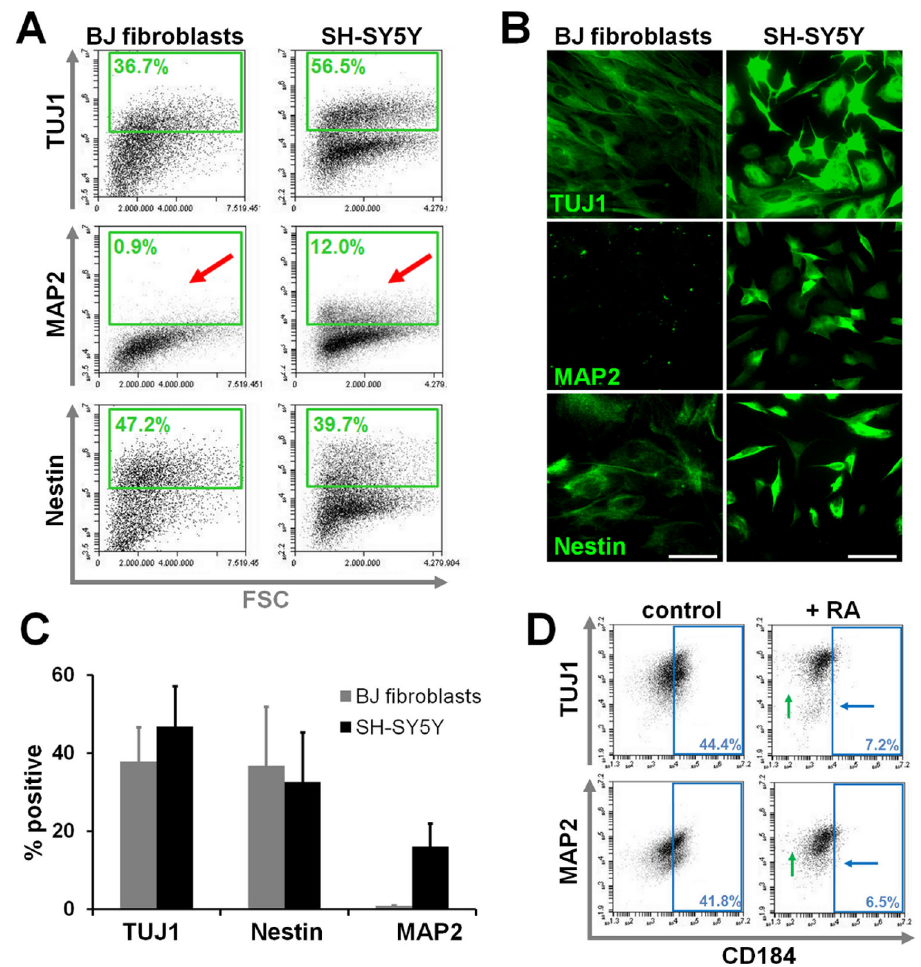
Figure 3. Accurate detection of intracellular antigens with optimized fixation-permeabilization conditions preserving surface antigens. Flow cytometric detection of TUJ1, MAP2 and nestin antigens in BJ fibroblasts and the neural SH-SY5Y cell line (A). TUJ1 and nestin are present in both cell lines, while the mature neuronal marker MAP2 was only detected in SH-SY5Y cells (arrows). Note stable fluorescent levels of the negative population, indicating low background staining using this protocol. Representative experiment of three independent repeats shown. ( B ) Corresponding validation by immunofluorescence analysis. ( C ) Quantitation of TUJ1, MAP2 and nestin intracellular antigen detection (n=3). Error bars indicate standard deviation. ( D ) Response of TUJ1 and MAP2 intracellular antigen expression to 6 DIV of 10 µM retinoic acid (RA) treatment of SH-SY5Y cells. Note disappearance/reduction of subsets negative for these markers (upward shift, green arrows), as well as a shift toward CD184 low expression with differentiation (blue